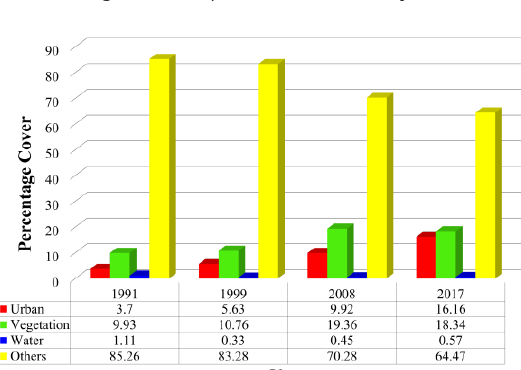
Figure 5: Temporal Land Use Analysis